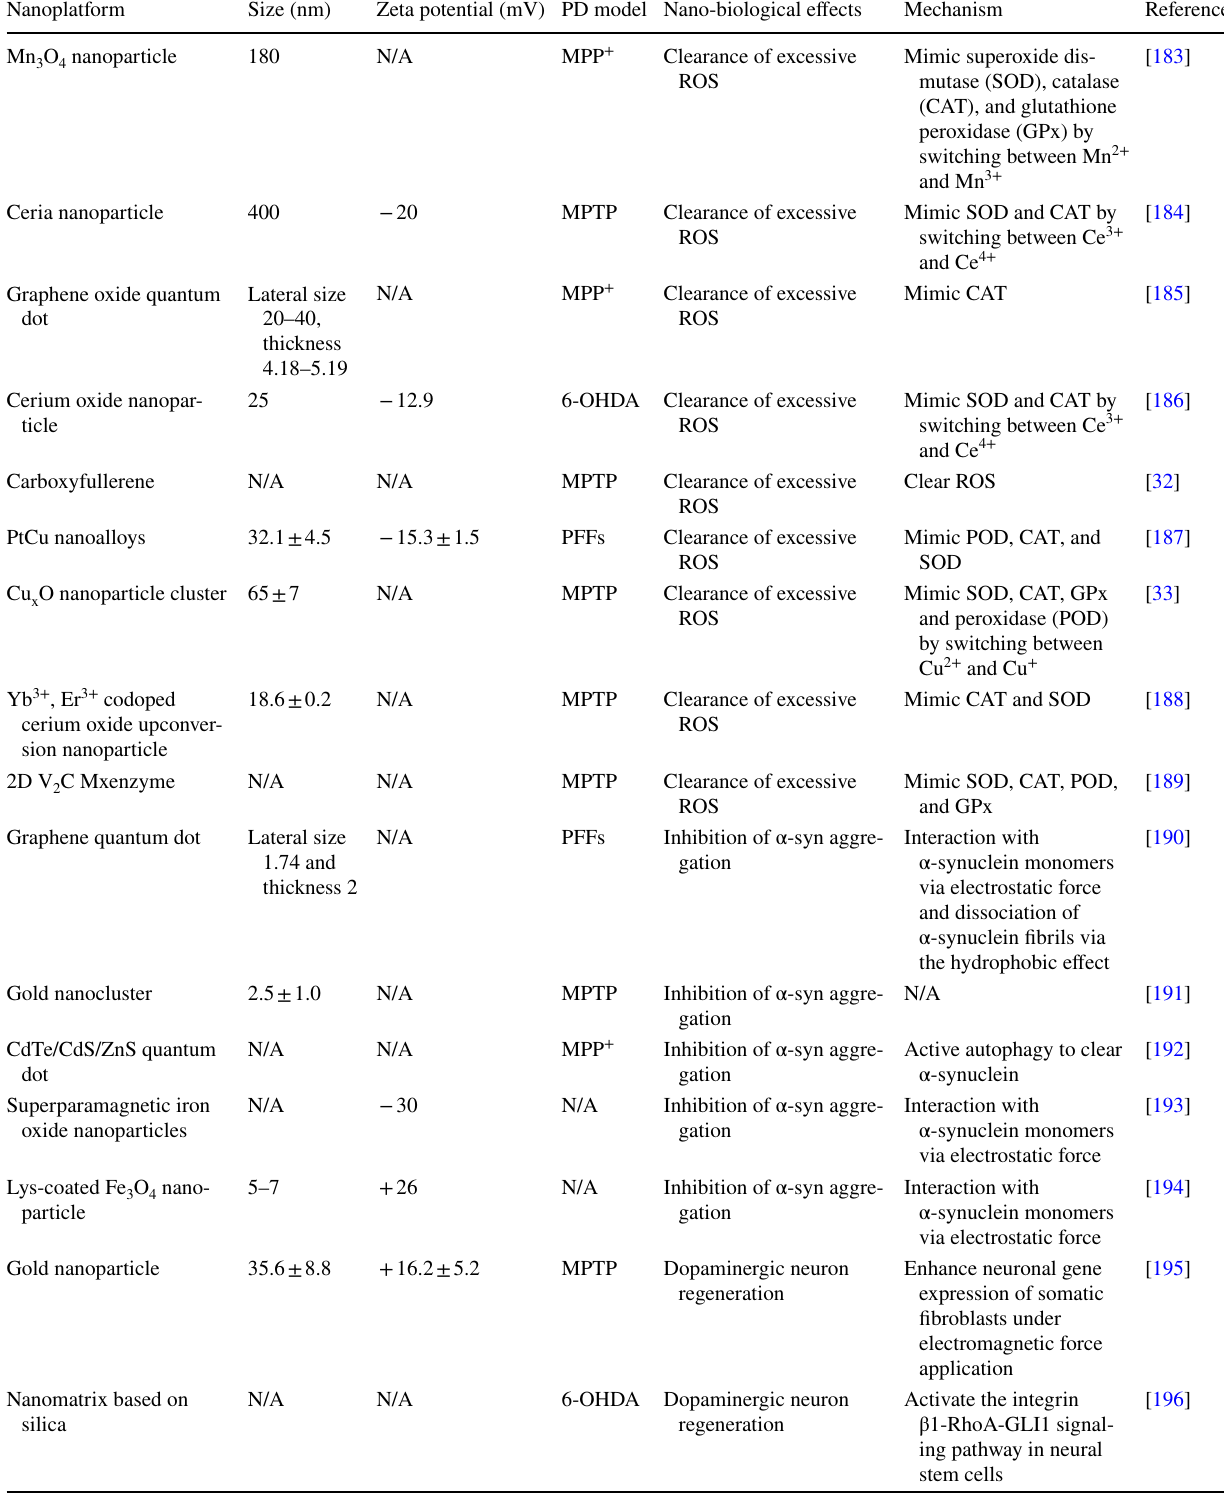
Table 3 Nanomaterials with anti-Parkinsonian nano-bio effects